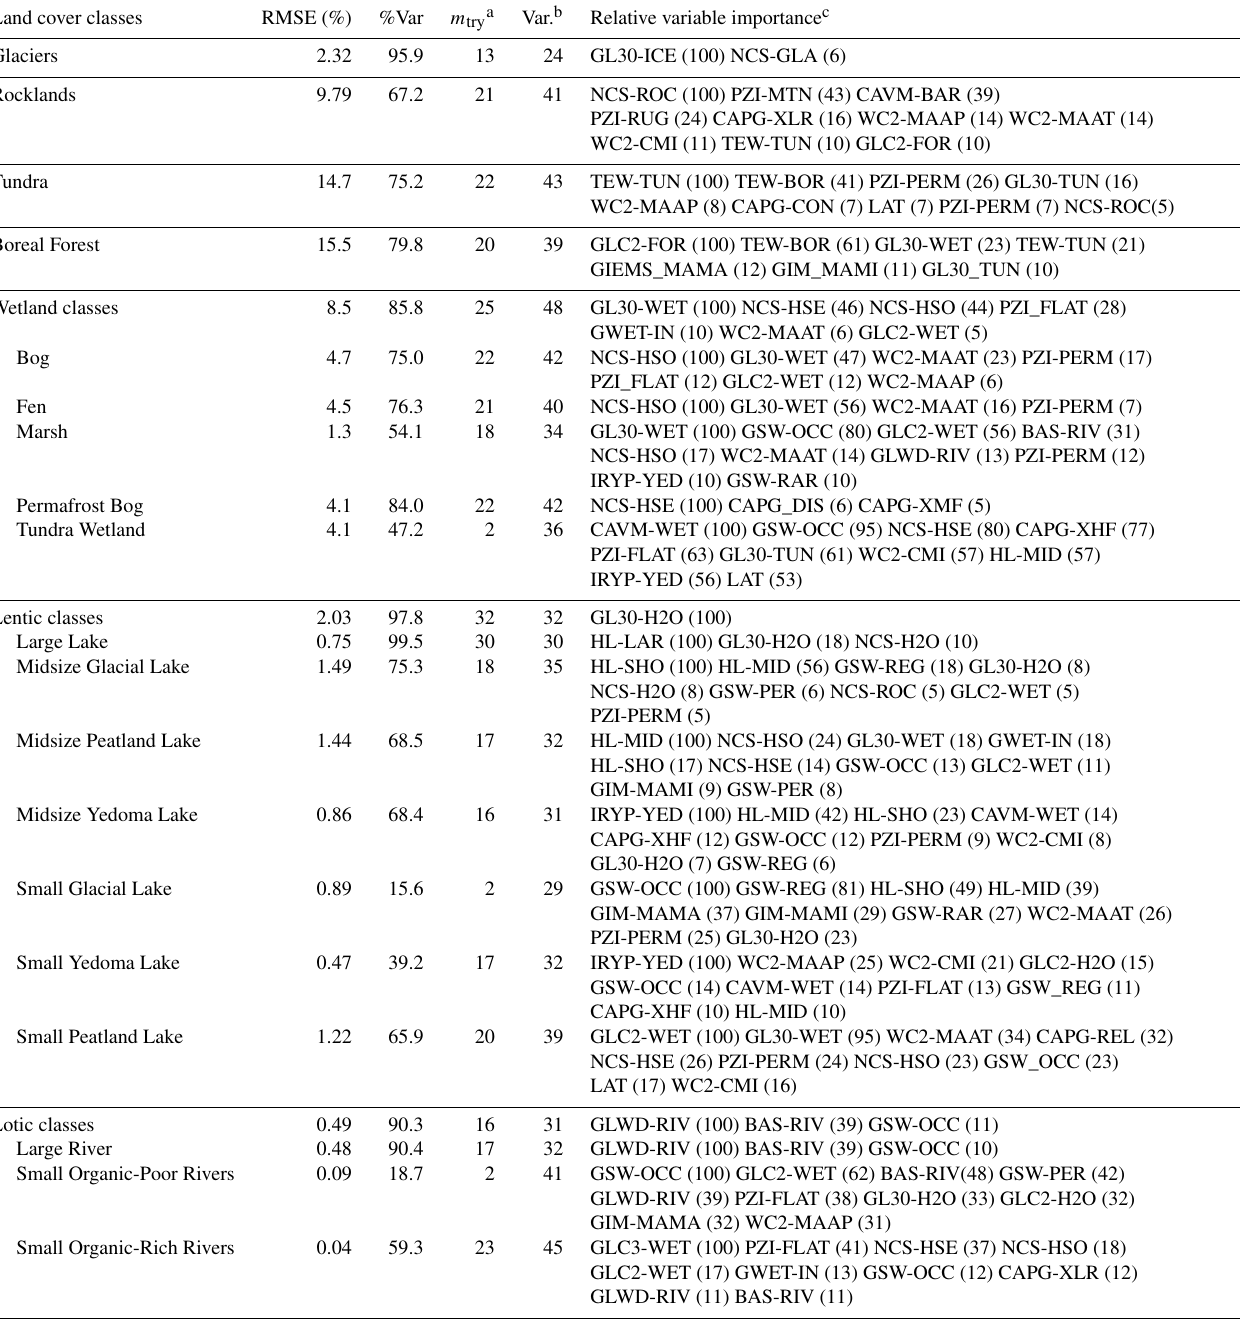
Table 2. Summary of random forest models for each land cover class in BAWLD. Land cover